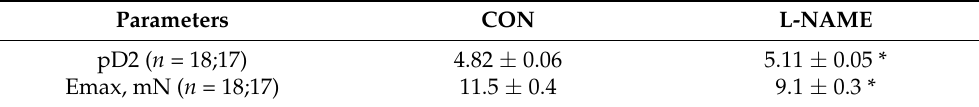
Table 3. Results of concentration–response relationship approximations of control (CON) and L- NAME offspring to a sigmoidal dose–response equation.